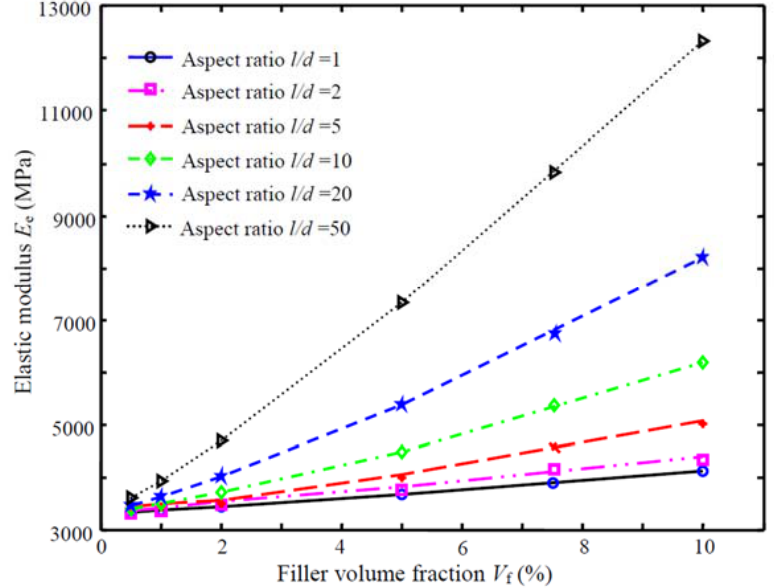
Figure 4. Variation of the effective elastic modulus E e with the filler volume fraction V f .